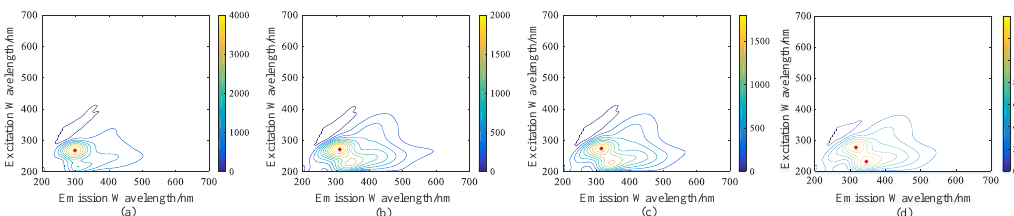
Figure 4. Spectral images of ( a ) 40 µ g / L phenol; ( b ) 10 µ g / L phenol; ( c ) 4 µ g / L phenol; and Figure 4. Spectral images of ( a ) 40 μg/L phenol; ( b ) 10 μg/L phenol; ( c ) 4 μg/L phenol; and ( d ) drinking ( d ) drinking water. Figure 4. Spectral images of ( a ) 40 μg/L phenol; ( b ) 10 μg/L phenol; ( c ) 4 μg/L phenol; and ( d ) drinking water. Figure 4. Spectral images of ( a ) 40 μg/L phenol; ( b ) 10 μg/L phenol; ( c ) 4 μg/L phenol; and ( d ) drinking water.